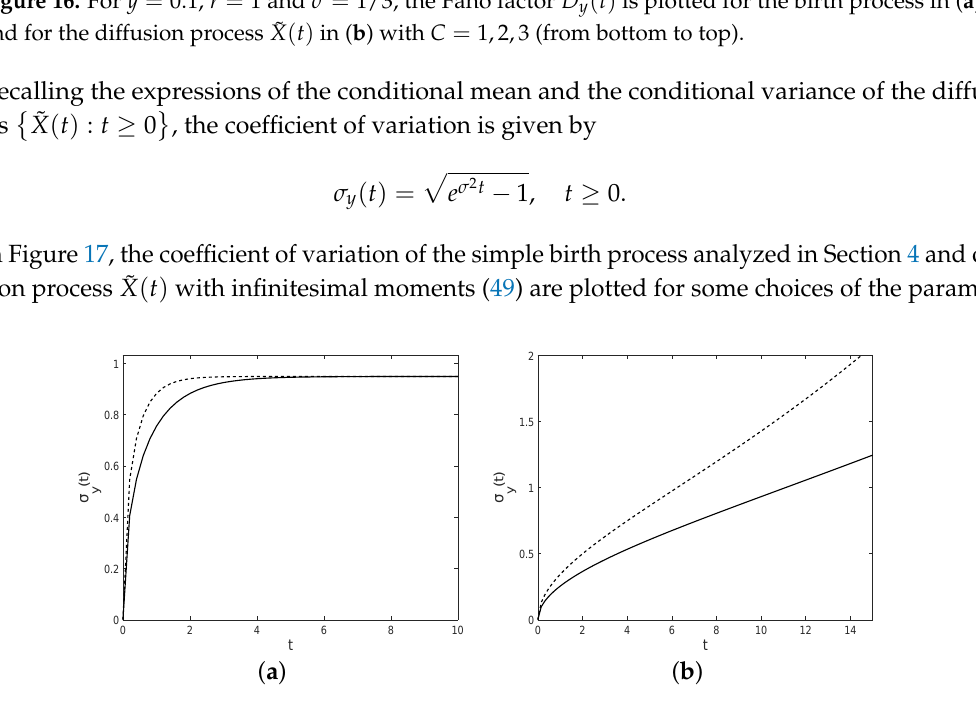
Figure 17. For y = 1, C = 10 the coefficient of variation σ y ( t ) is plotted for the birth process in ( a ) with r = 1 (solid line) and r = 2 (dashed line) and for the diffusion process in ( b ) with σ = 1/4 (solid line) and for σ = 1/3 (dashed